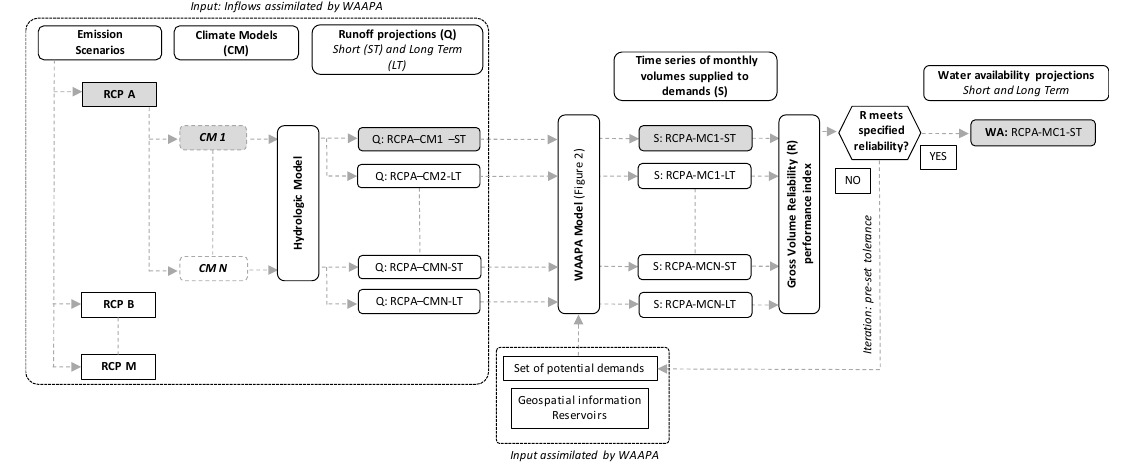
Figure 1. General scheme of the applied methodology. The displayed procedure was applied to each defined sub-basin. Grey areas indicate the first path carried out, from the selection of the emissions scenario to the estimation of the water availability.